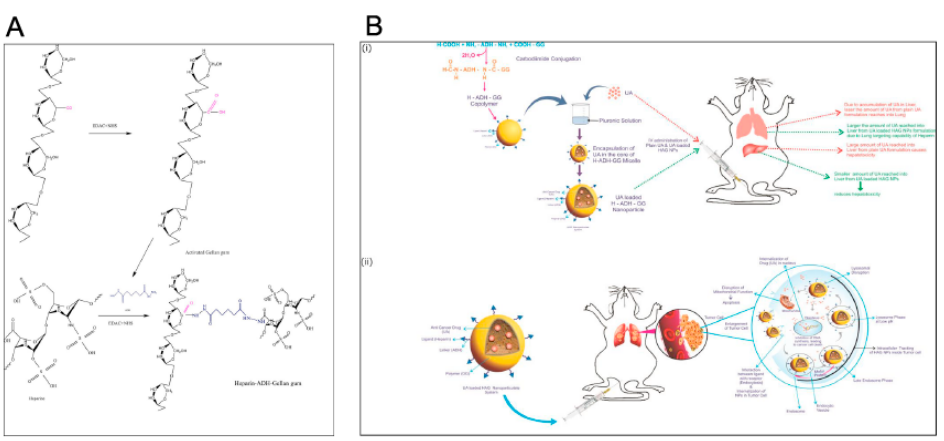
Figure 5. Synthetic scheme of ( A ) heparin-adipic acid dihydrazide copolymer (HAG) copolymer; ( B )